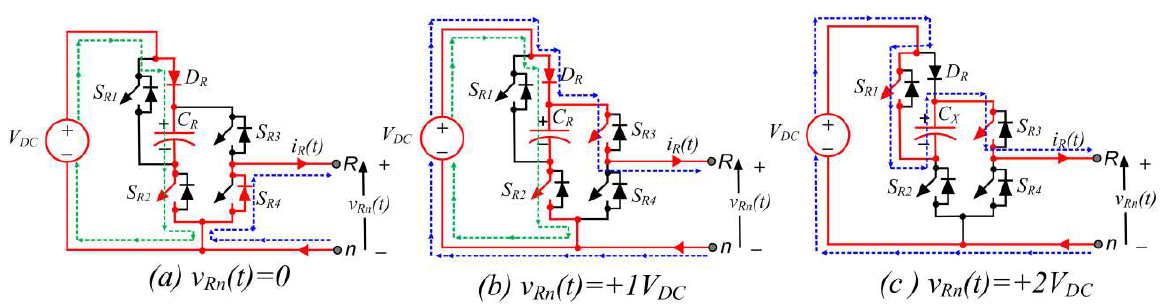
Figure 3. Different modes of operation of pole voltage generation. ( a ) 𝑣 (cid:3019)(cid:3041) (𝑡) = 0; ( b ) 𝑣 (cid:3019)(cid:3041) (𝑡) = 1V DC ; ( c ) 𝑣 (cid:3019)(cid:3041) (𝑡) = 2V DC .